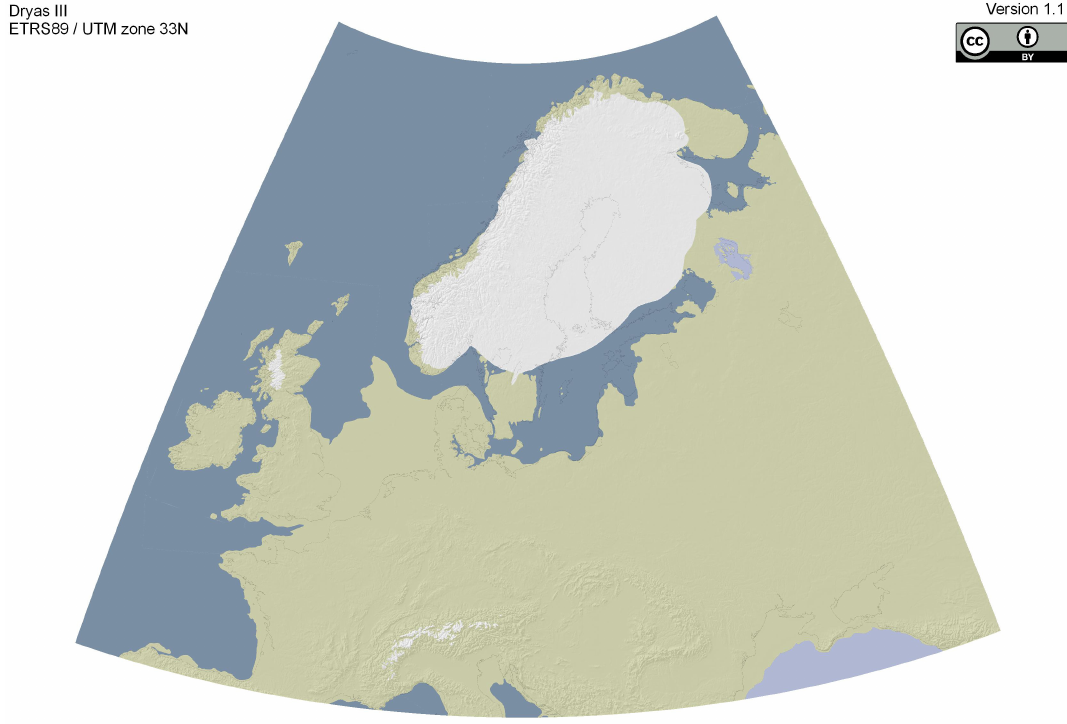
Figure 4. One of the prerendered maps (Younger Dryas) as provided by the European Prehistoric and Historic Atlas (EPHA)-project